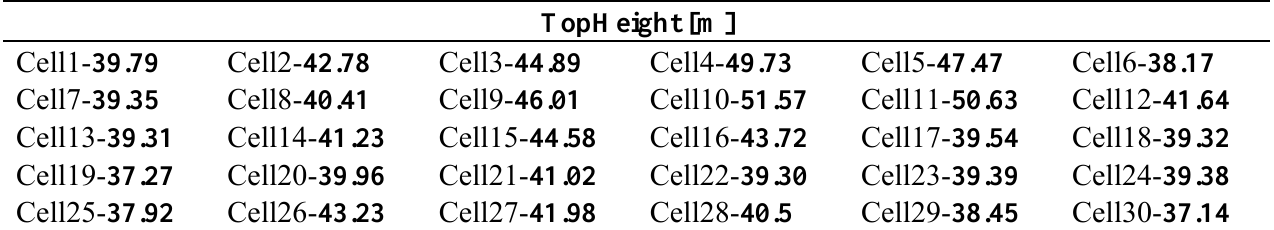
Table 1. Top height (in meters) of 30 cells of 20 m × 20 m size each.